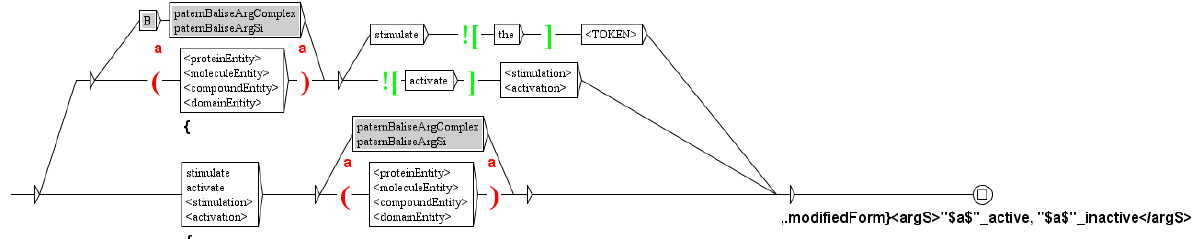
Figure 9. The graph to tag predicates of type modifiedForm